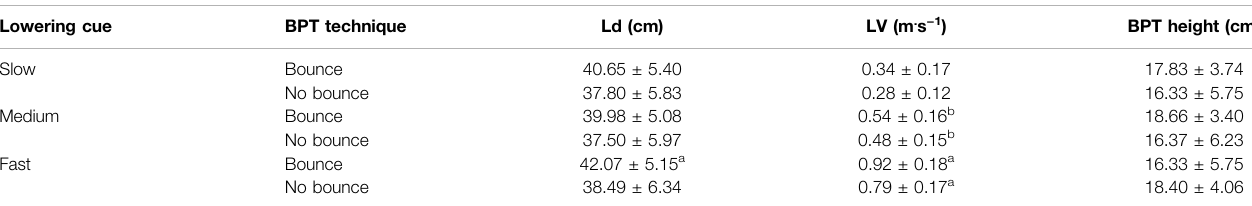
a Signi fi cant difference compared to the other lowering cues. b Signi fi cant difference compared to “ slow. ” Ld, lowering displacement; LV, lowering velocity; BPT, bench press